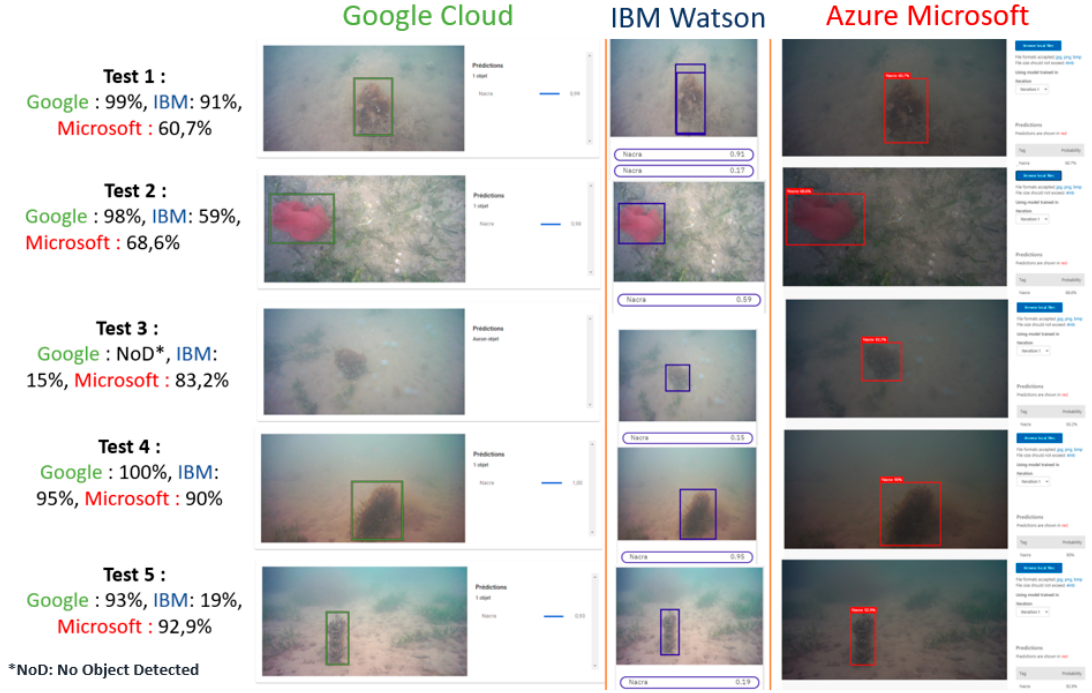
Figure 15. Cloud-based custom models for detecting new specimens.